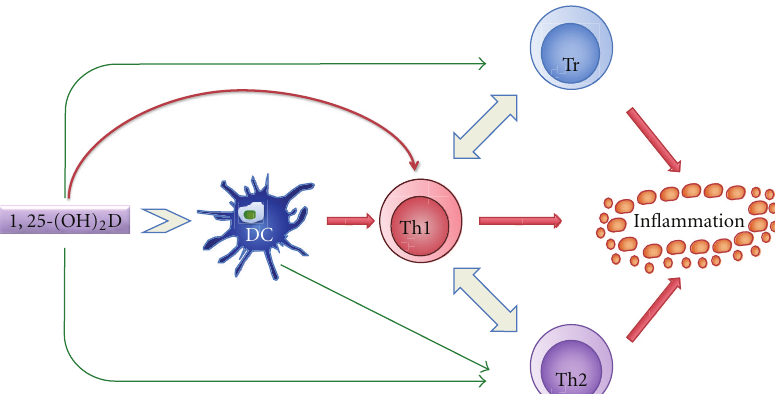
Figure 3: The in vitro e ff ects of 1,25(OH) 2 D on the immune system. The e ff ects of 1,25(OH) 2 D either directly or indirectly are depicted by arrows. While a green arrow represents positive influence, a red arrow represents the negative influence. The negative influence on inflammation indicates dampening of the inflammatory response. DC: dendritic cell; Th1: T helper type 1 lymphocyte; Th2: T helper type 2 lymphocyte; Tr: regulatory T lymphocyte